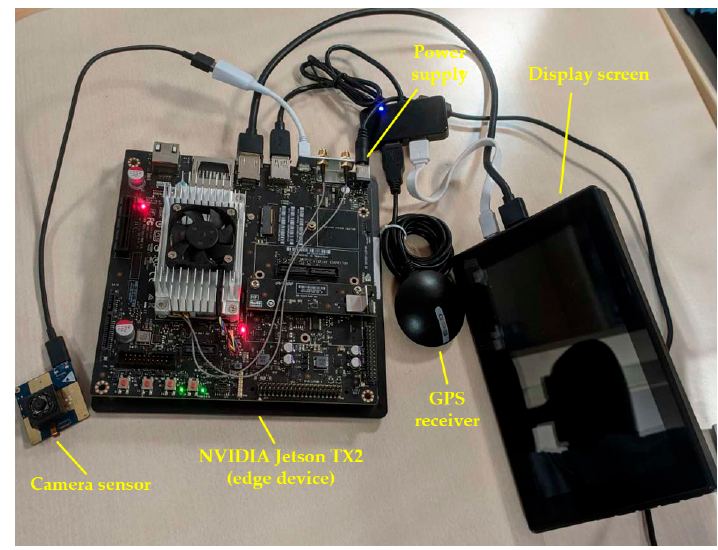
Figure 2. Hardware components of the VAEC’s